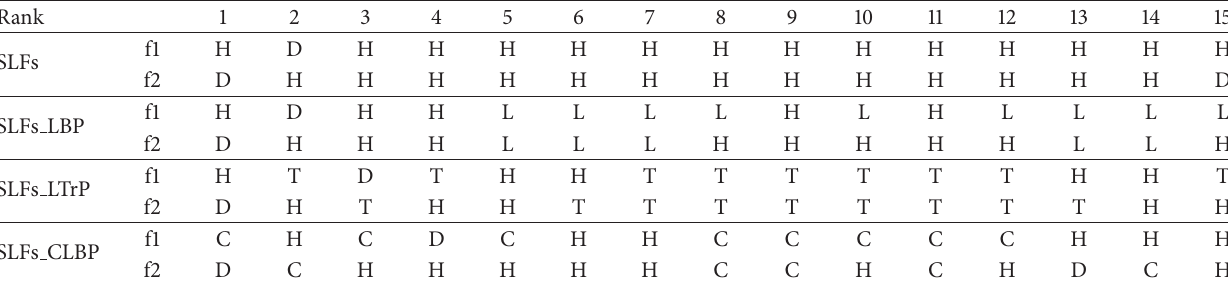
Table 2: An illustration of features rank obtained by SDA for the combination of each of three local pattern features and global features in db6 of training set of each 2-fold.